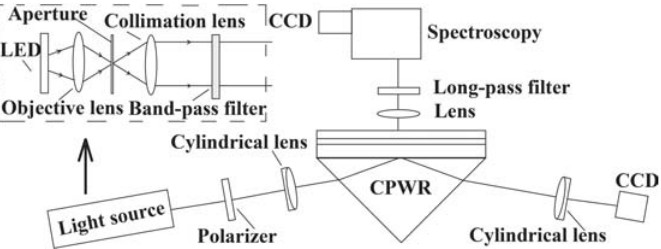
Fig. 2. Schematic of a sensor suitable for simultaneous detections of CPWR and hyperspectral °uorescence